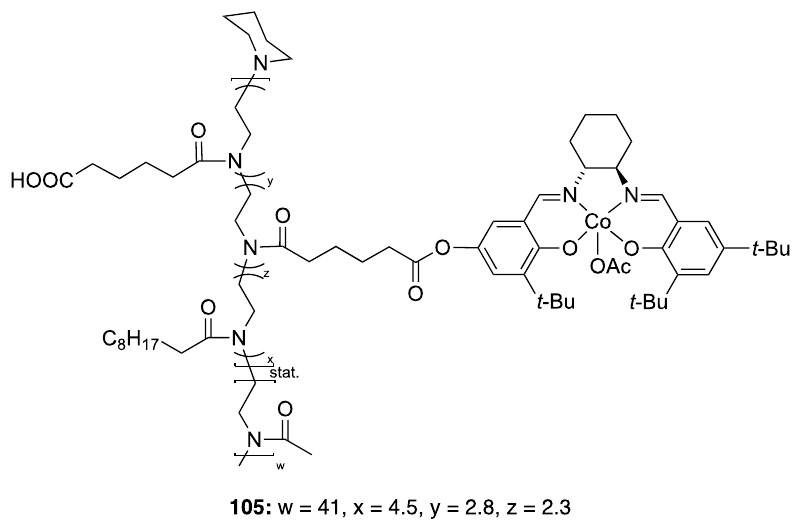
Figure 39. Amphiphilic copolymerized Co–salen catalyst 105 .